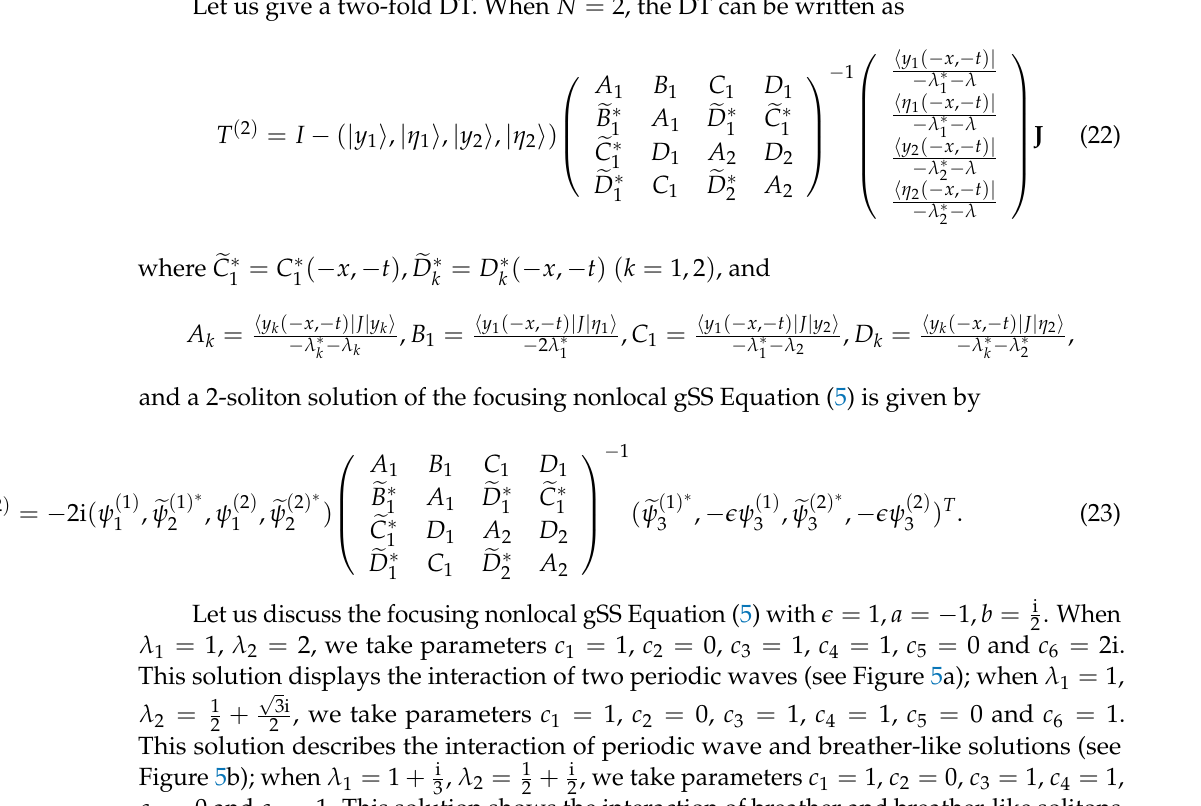
: ( a , d ) periodic-like solution with √ 5 3i; ( c , f ) breather solution with λ 1 = 1 +